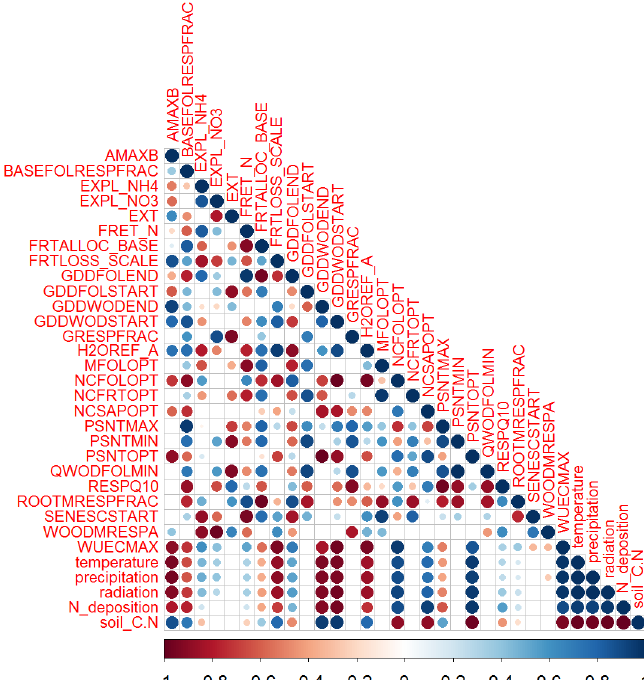
Figure 3. Combined correlation matrix of calibrated parameter values and site properties for Scot pine forests. The correlation is given by r 2 values. The size of the circles relates to the level of significance: small circles indicate significance between 0.01 and 0.05 while big circles correspond to high significance (<0.01). Blank cells indicate that no significant values are obtained ( p > 0.05). For parameter descriptions, see Table 2. Environmental properties are given in lowercase characters (temperature in annual means, precipitation and N deposition as annual sums and soil C:N ratio for the first 5 cm soil depth) while model parameters are in uppercase characters.